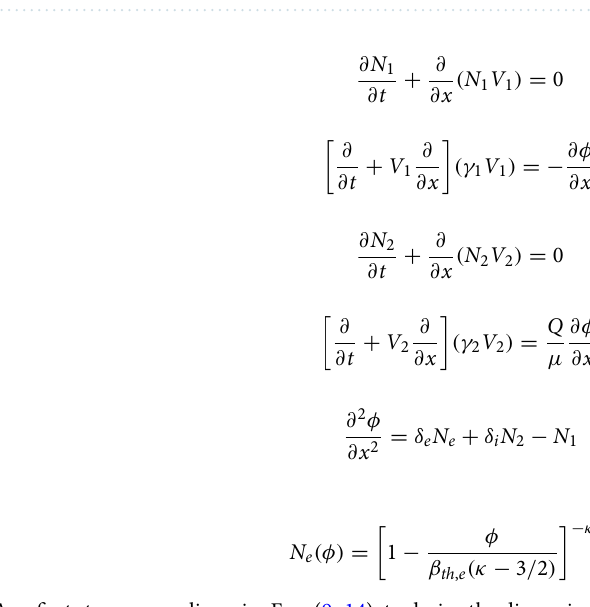
Figure 1. Dispersion curves of electrostatic waves in an electronegative plasma. Left: For different values of negative ion concentration and Right: For different values of electron thermal energy. Other parameters are kept constant as